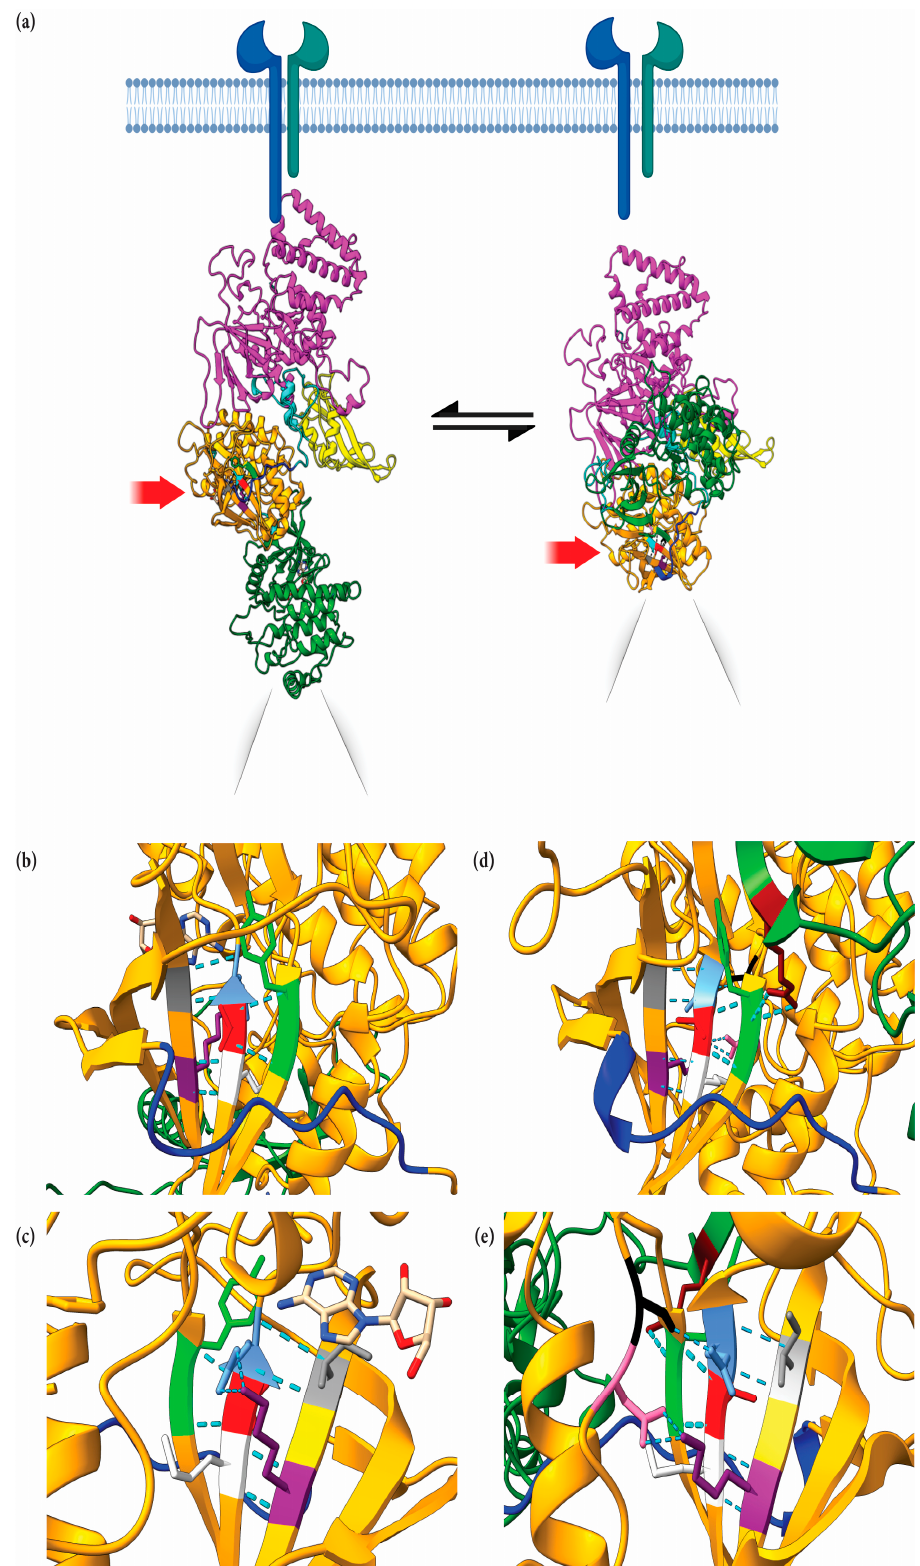
Figure 6. Structural implications of JAK1 V666 modeled in open and closed enzymatic configurations. ( a ) The N-terminal 4.1 protein, ezrin, radixin, moesin domain (FERM, pink), Src homology domain (SH2, yellow), pseudokinase (orange), and C-terminal kinase domain (green) are depicted within the open-kinase (left side) and closed-kinase form (right side). V666 (red) is depicted within the